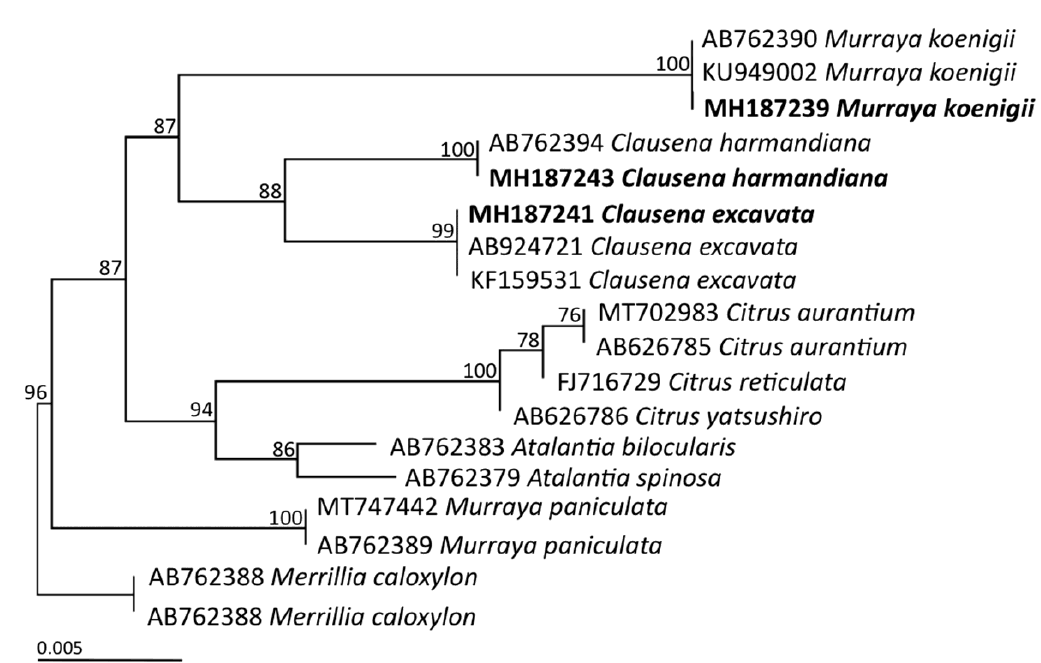
Figure 2. Phylogenetic tree derived from maximum likelihood analysis of the mat K gene of 18 sequences. Bar represents 0.005 substitutions per nucleotide position. The plants from this study are presented in bold.